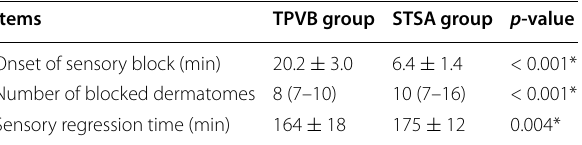
Data are expressed as mean significant